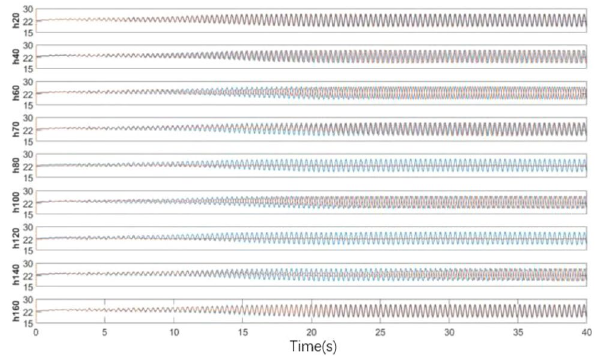
Figure 29. Time domain diagram of length of spoiler (The blue data is the speed of the original simplified model, and the red data is the modified speed curve).